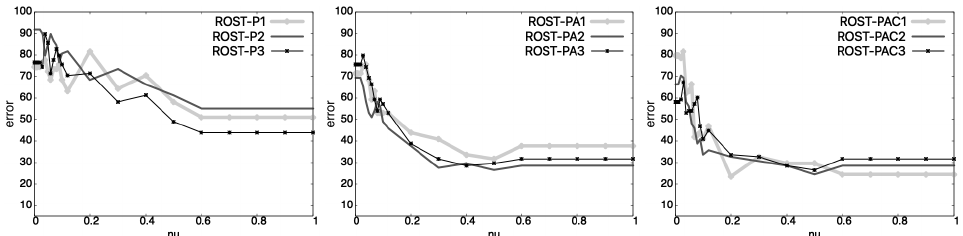
Figure A6. SVM results on the considered datasets. In total, 30 runs are performed with nu varying from 0.001 to 1. The percentage of incorrectly classified data is